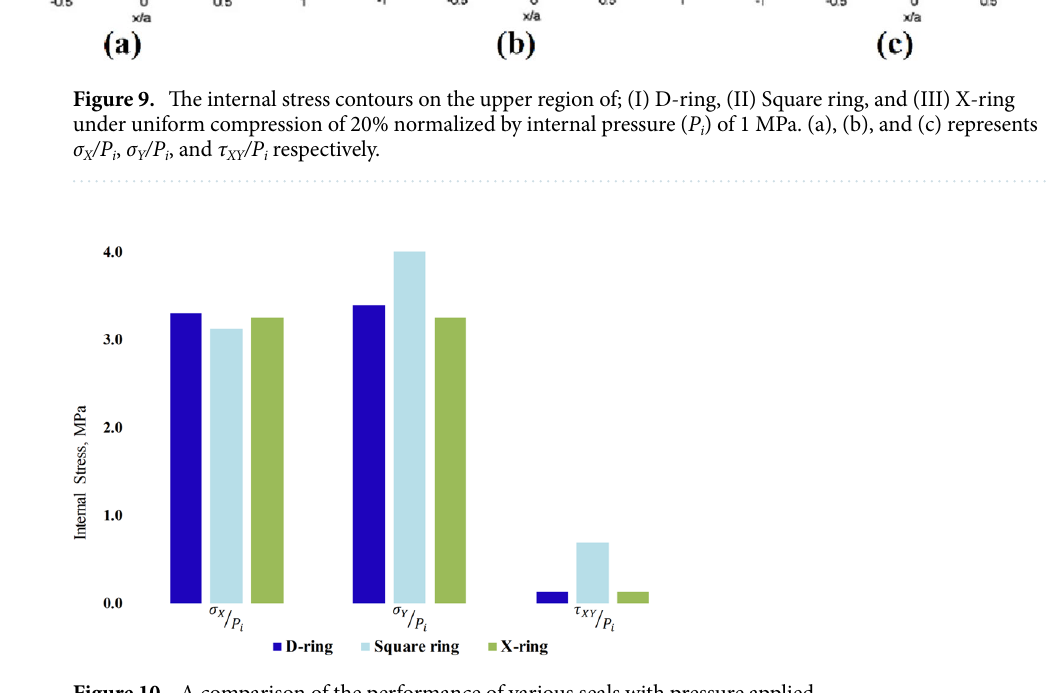
Figure 10. A comparison of the performance of various seals with pressure